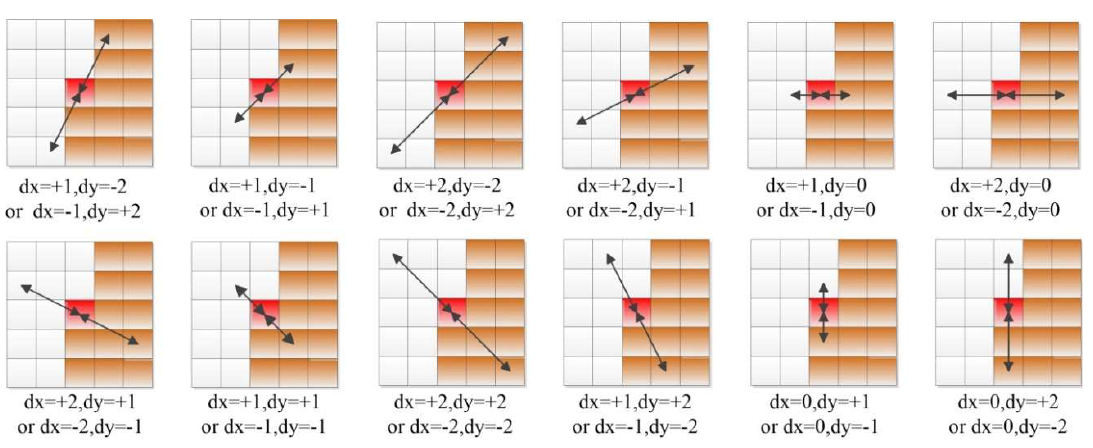
Figure 4. The 12 displacement vectors in the 5 × 5 window.